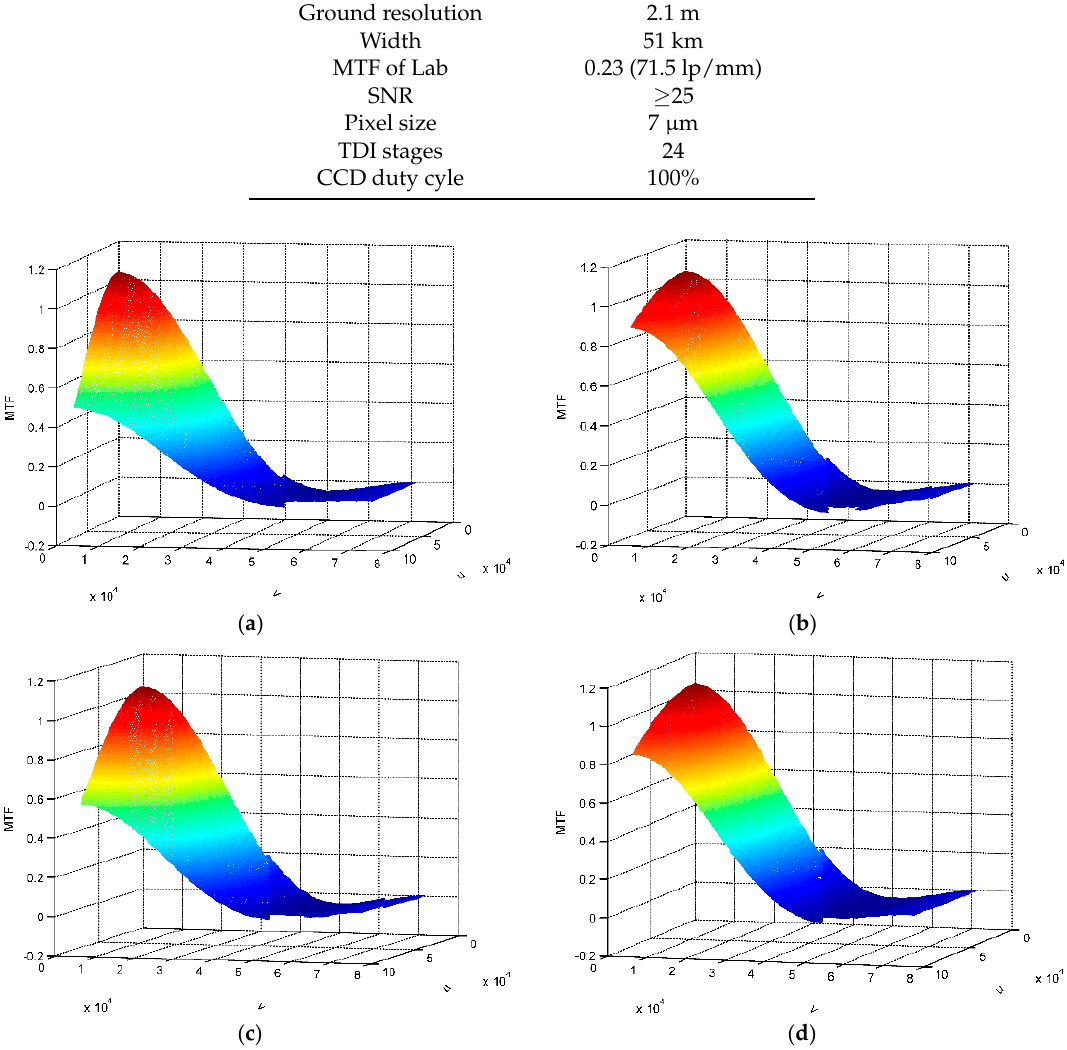
Figure 10. Modulation transfer function (MTF) of different sampling positions in TDI–CCD. ( a ) MTF of single TDI-CCD; ( b ) MTF of sampling points in the best position; ( c ) MTF of sampling points with the serious offset; ( d ) MTF of sampling points with the minor offset.